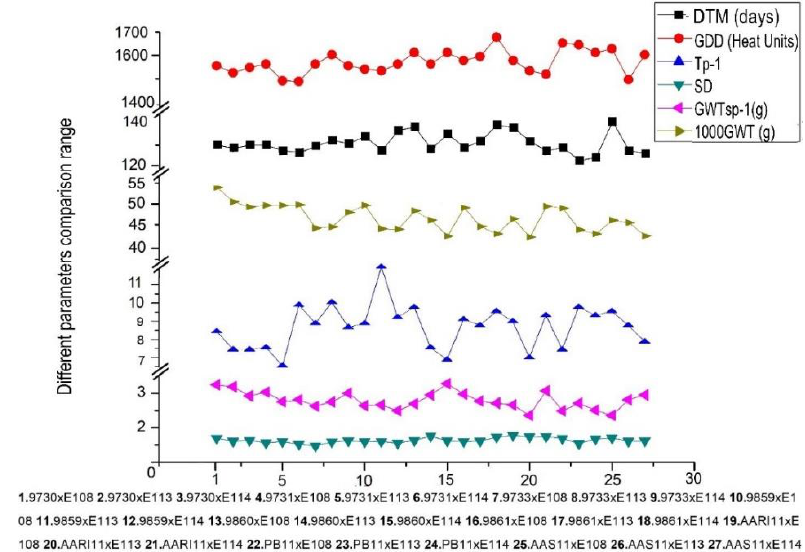
Figure 2. Mean performance for 27 F 1 compared at Lease Significant Difference (LSD) 0.05 . DTM, Days to 50% maturity; GDD, Growing degree days (heat unit); Tp − 1 , Productive tiller plant − 1 ; SD, Spike density; GWTsp − 1 , Grain weight spike − 1 (g); 1000 GWT, 1000 grain weight (g). Figure’s data can be found at Table S2.